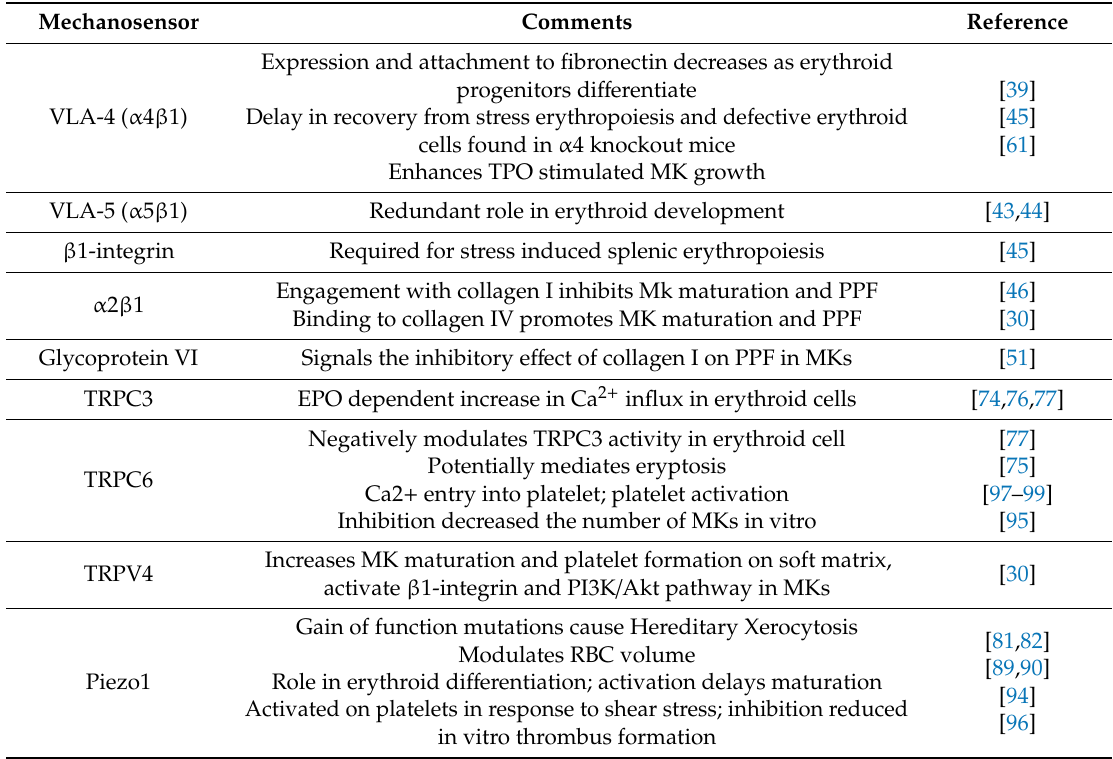
Table 1. Erythroid and megakaryocyte